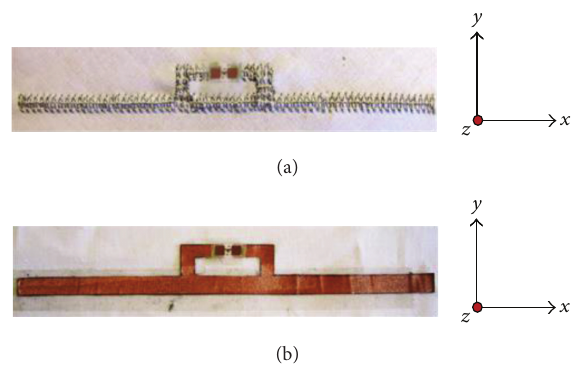
Figure 14: Electrotextile tags used for the human body model verification: (a) embroidered tag antenna and (b) fabric tag antenna. A NXP IC is attached using conductive silver epoxy